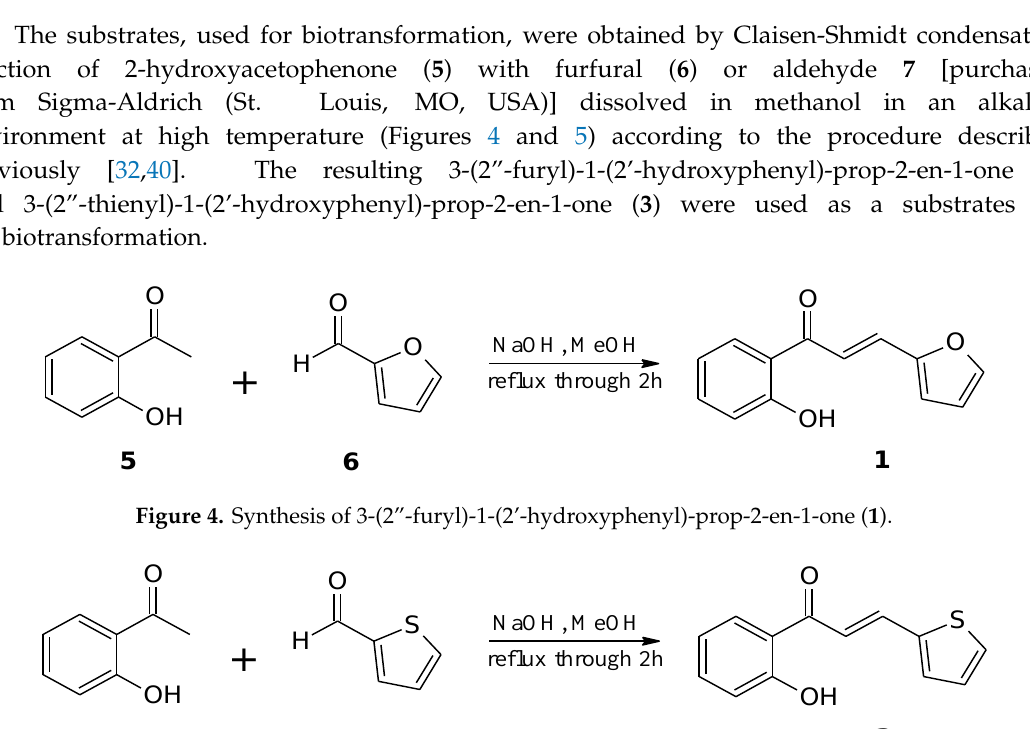
Figure 3. Biotransformation of 3-( 2” -thienyl)-1- (2’ -hydroxyphenyl)-prop-2-en-1-one ( 3 ) by selected yeast cultures.